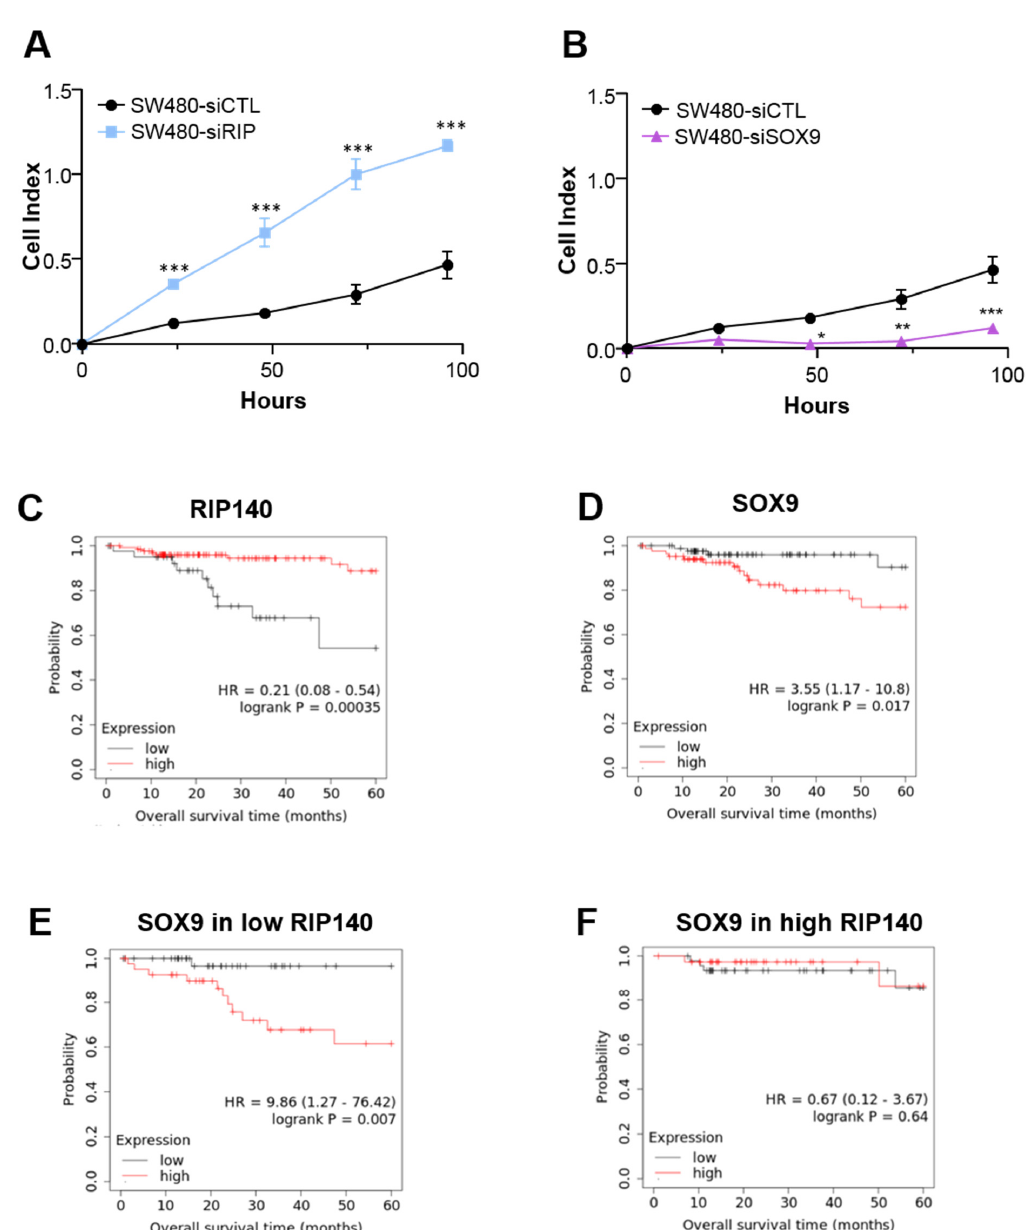
Figure 5. Cell index corresponding to the number of SW480 CRC viable cells, without (SW480 -control) or with siRNA- mediated knock-down of ( A ) RIP140 (SW480 -siRIP) or ( B ) SOX9 expression (SW480-siSOX9) A Student t test was used for statistical analysis: * p < 0.05, ** p < 0.01, and *** p < 0.001. ( C , D ) Kaplan-Meier analysis performed on TCGA RNA-seq data using the Kaplan–Meier plotter database. Patients were ranked according to RIP140 ( C ) or SOX9 ( D ) gene expression in their tumors and divided into two groups exhibiting low and high expression, respectively (best cut-off threshold). ( E , F ) Kaplan-Meier analysis of the cumulative OS of patients with low or high SOX9 gene expression (same cut-off used in panel ( D ) was performed on the groups exhibiting low or high RIP140 gene expression. A log-rank test was used for statistical analysis.